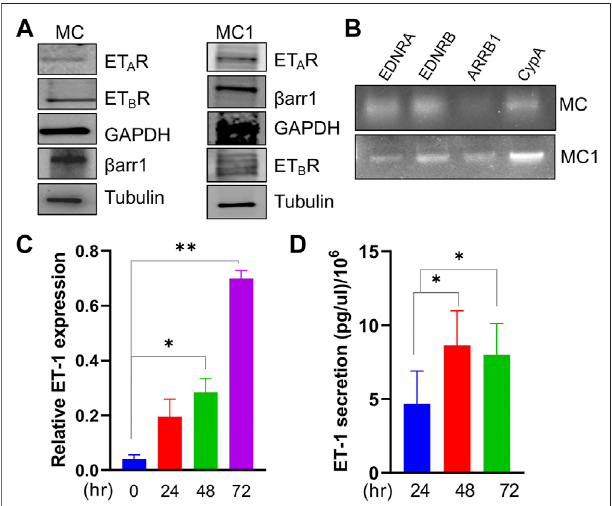
FIGURE 1 | Mesothelial cells express ET A R and ET B R along with β -arr1 and secrete ET-1. (A) Representative Western Blotting (WB) analysis of ET A R andET B Rand β -arr1inMCsandMC1s.GAPDHandTubulinwereusedasthe loading control. (B) Representative RT-PCR analysis showing ET A R, ET B R and β -arr1 mRNA levels in MCs. CypA was used as a loading control. (C) ET-1 expression evaluated by qPCR in MCs at 24, 48, and 72 h (D) ET-1 secretion evaluated by ELISA assays in MC culture medium at 24, 48, and 72 h. Histograms, the mean ± SD, n (cid:2) 2. One-way